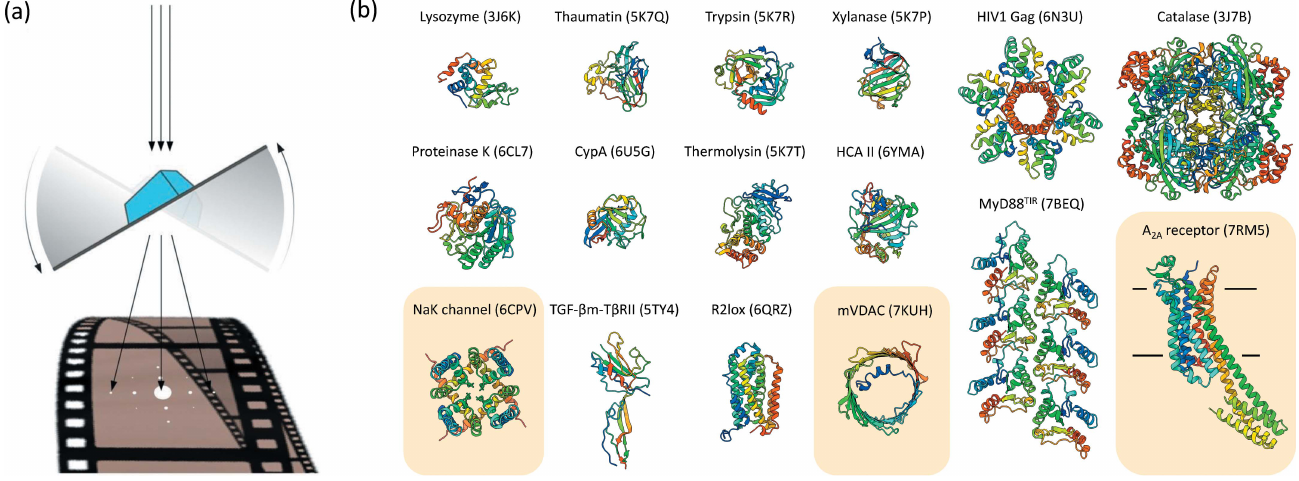
Figure 1 The MicroED method and examples of some structures. ( a ) Illustration of MicroED data collection where the crystal is continuously rotated and diffraction patterns are recorded as a movie. ( b ) Examples of several protein structures determined by MicroED are listed with their names and PDB identifiers. Proteins are shown in their biological assembly and membrane proteins are highlighted in